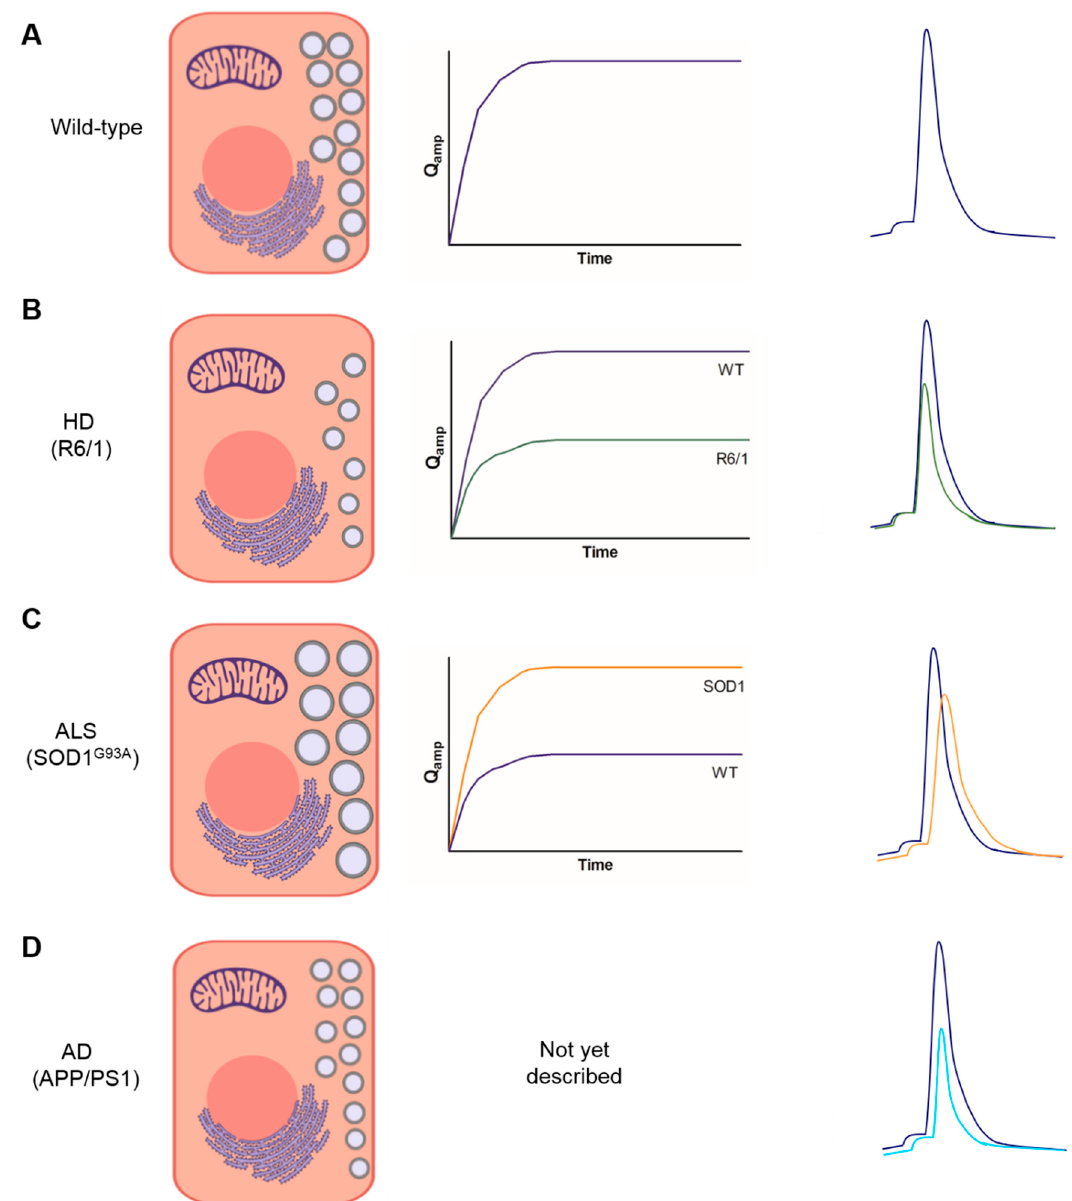
Figure 2. Schematic representation of altered exocytosis in chromaffin cells (CCs) from wildtype mice (WT) and mice carrying a mutation of Huntington’s disease (HD, R6/1), amyotrophic lateral sclerosis (ALS, SOD1 G93A ), and Alzheimer’s disease. CCs were stimulated with 1-min pulses of acetylcholine (ACh); bulk secretion (summatory areas of all spikes recorded in 1-min ACh stimulation) is represented in the middle traces (Qamp versus time) and the averaged modelled single-spike kinetics are represented in the right traces. ( A ), typical time-course secretory curve and a representation of a spike with foot and the parameters measured in each individual spike. ( B ), bulk secretion and spike kinetics in WT and R6/1 CCs [28]; ( C ), bulk secretion and spike kinetics in SOD1 G93A CCs [29]; ( D ), cumulative bulk secretion was not monitored in this study; overlapping WT and APP/PS1 spikes are represented on the right part of this panel [33]. See text for further explanation.